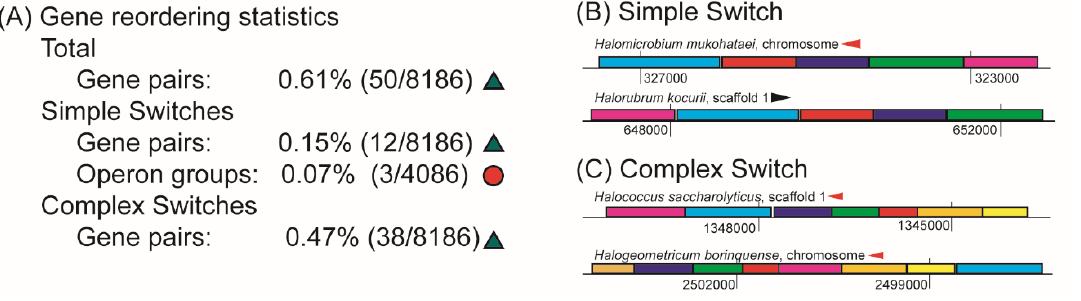
Figure 5. Modification by gene reordering. ( A ) Frequencies of gene reordering observed among adjacent gene pairs (green triangle) and identical content groups (red circle). These could be further segregated into simple switches (gene reordering does not accompany modification in gene content) and complex switches (gene reordering accompanies modification in gene content). Two examples are shown: a simple switch ( B ) and a complex switch ( C ). In ( B ), light blue, red, dark blue, green, and pink genes are a glycerol-3-phosphate ABC transporter, ugpA, ugpE, ugpC, and glycerophospohryl diester phosphodiesterase, respectively. In ( C ), pink, light blue, dark blue, green, red, tan, yellow, and mocha genes are dimethylbenzimidazole phosphoribosyltransferase, cobyrinic acid A,C-diamide synthase, adenosylcobinamide-phosphate synthase, cobalamin synthase, CobY, L-threonine 3-O-phosphate decarboxylase, adenosylcobinamide amidohydrolase and a “conserved cobalamin OLS protein”,